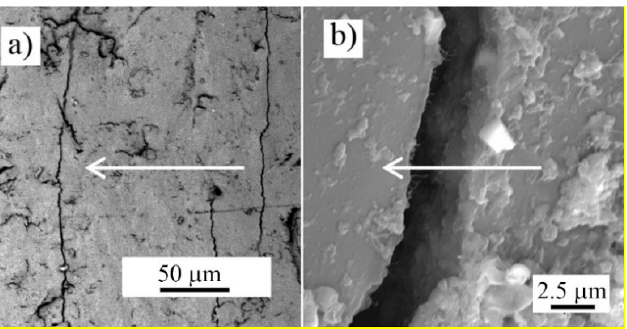
Figure 5. SEM micrograph of the surface of the MWCNT nanopaper/epoxy composite. ( a ) Cracks in the direction perpendicular to the direction of the strain (indicated by the arrow) appeared after the composite extension of 0.94% for 1 min at room temperature. ( b ) A detailed view of the